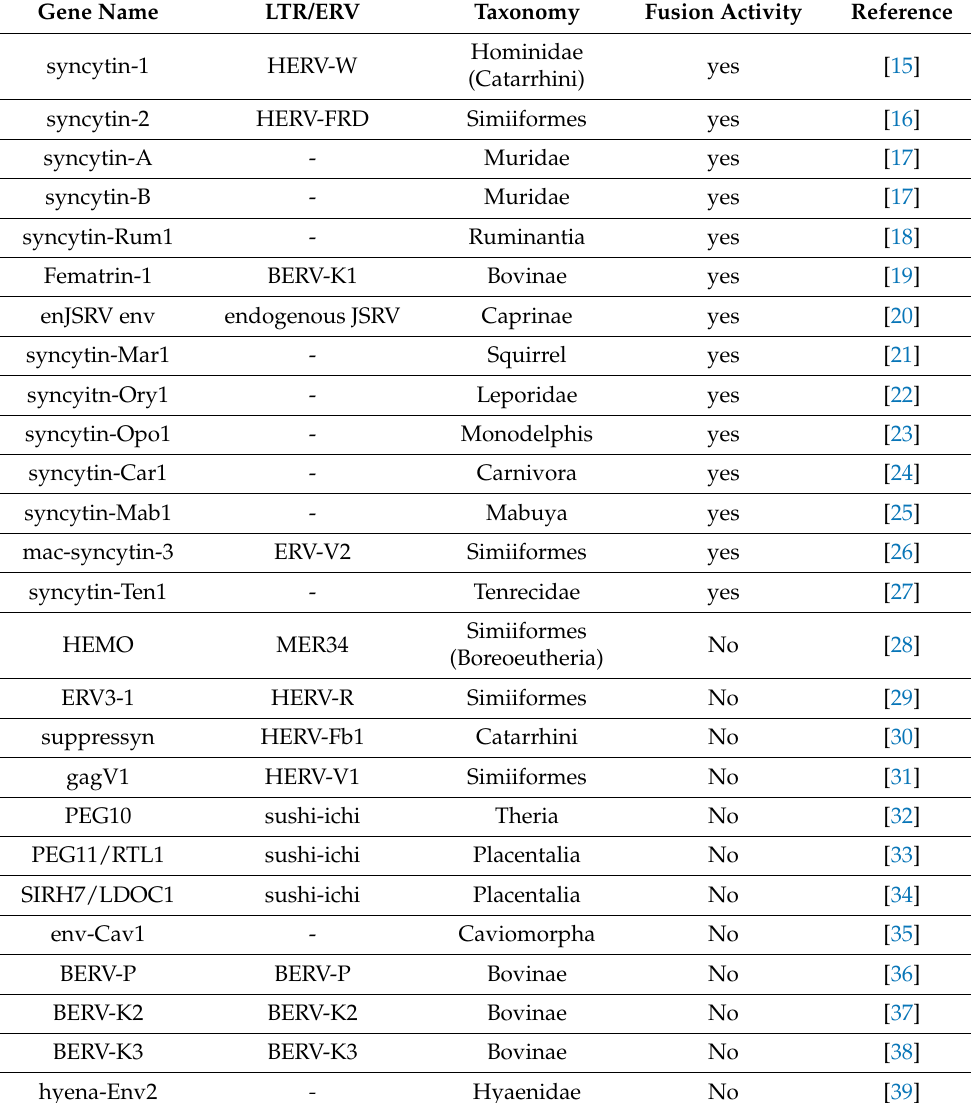
Table 1. ERV -derived genes expressed in the placenta (related to Figure